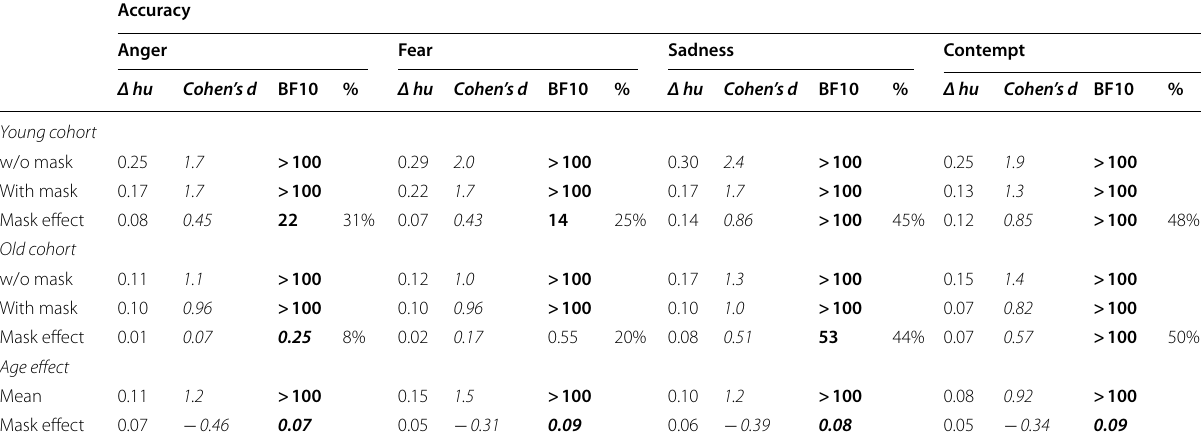
All comparisons are one-sided and signs indicate the direction of an effect relative to the prediction (see text). BF10 > 3 (at least moderate evidence for H1) are bold and BF10 < .33 (at least moderate evidence against H1) are bold and in italics. Δ hu , unbiased hit rate minus chance; %, relative decline due to face masks (relative to faces without masks)